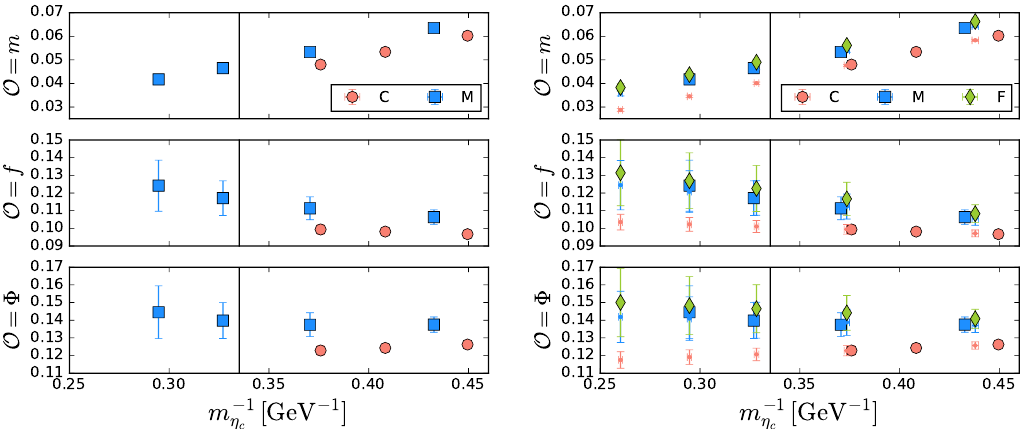
Figure 6 . Left : values of dimensionless parameters (cid:11) O as de(cid:12)ned in the text for C1 (red circles) and M1 (blue squares). Right : the same data overlaid with an extrapolation to the heavy quark choices of F1 (small red and blue symbols for C1 and M1, respectively). From this, the values of (cid:11) O for the (cid:12)ne ensembles F1 (green diamonds) are found, as outlined in the